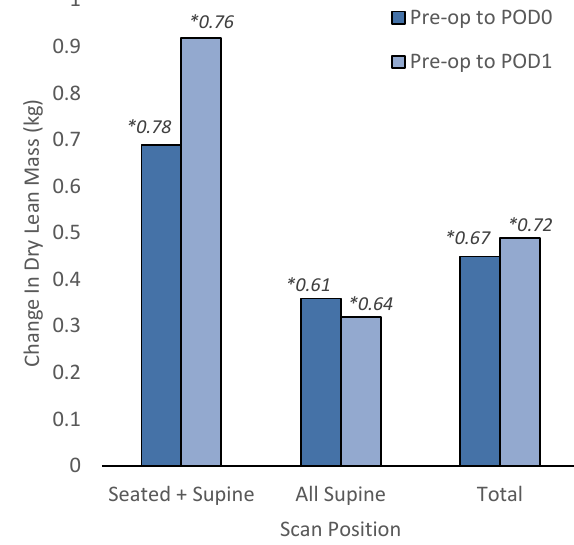
Figure 2. Comparison of means of change in dry lean mass (DLM) and scanning position from the pre-operative scan on the day of surgery to post-operative day 0 (POD0) and day 1 (POD1). * Denotes standard deviation